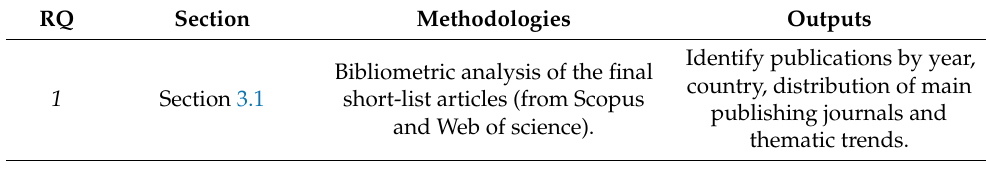
Table 1. Approaches to address the research